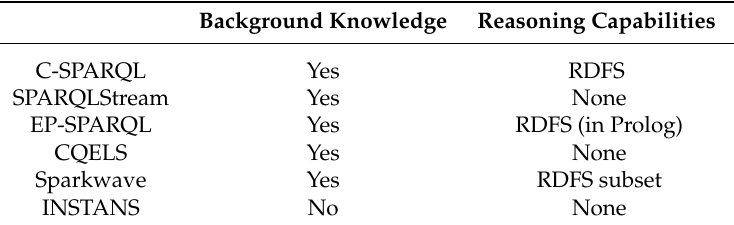
Table 1. Reasoning support in state-of-the-art RDF Stream Processing (RSP)